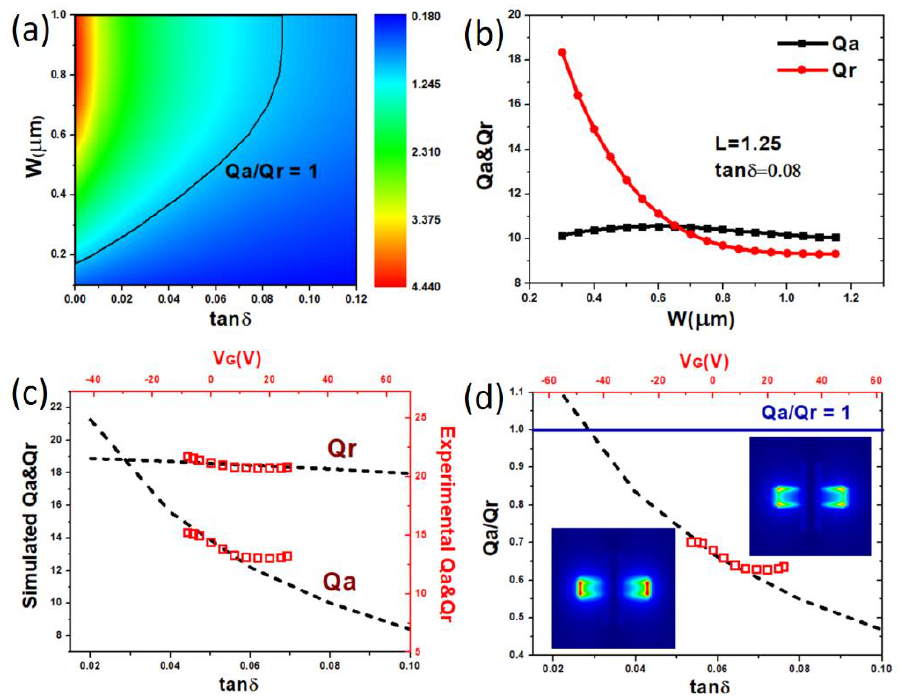
Figure 2. ( a ) The ratio between Q a and Q r , with di ff erent W and tan δ . ( b ) Q a and Q r change when L = 1.25 µ m and tan δ = 0.08. ( c ) Black dashed lines indicate the quality factor (Q a and Q r ) of the simulated results with fixed W, while red square dots show the experimentally tunable regime of graphene modulated by electricity. ( d ) Q a / Q r of the simulated and experimental results. 2D polarization images depict | E Z | distribution at V G = − 8 V and V G = 26